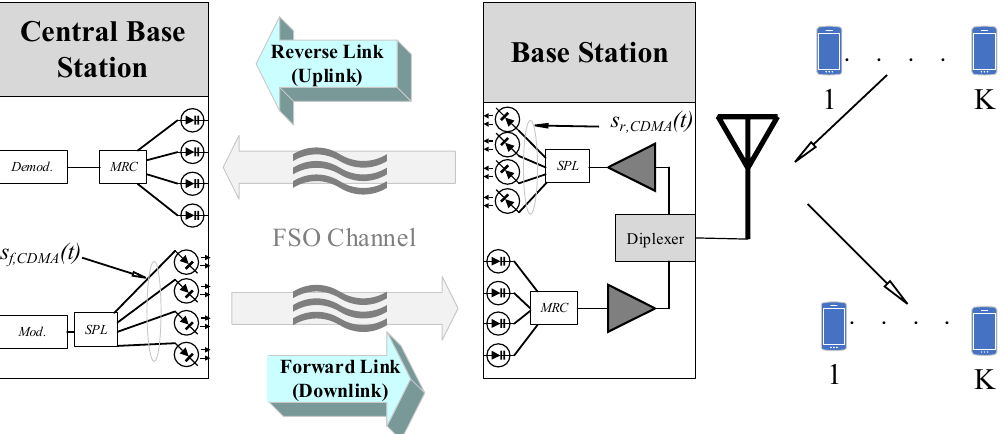
Figure 1. The system model for the CDMA RoFSO system with spatial diversity for both directions of the forward and the reverse link. (SPL: splitter, MRC: maximum ratio combiner).